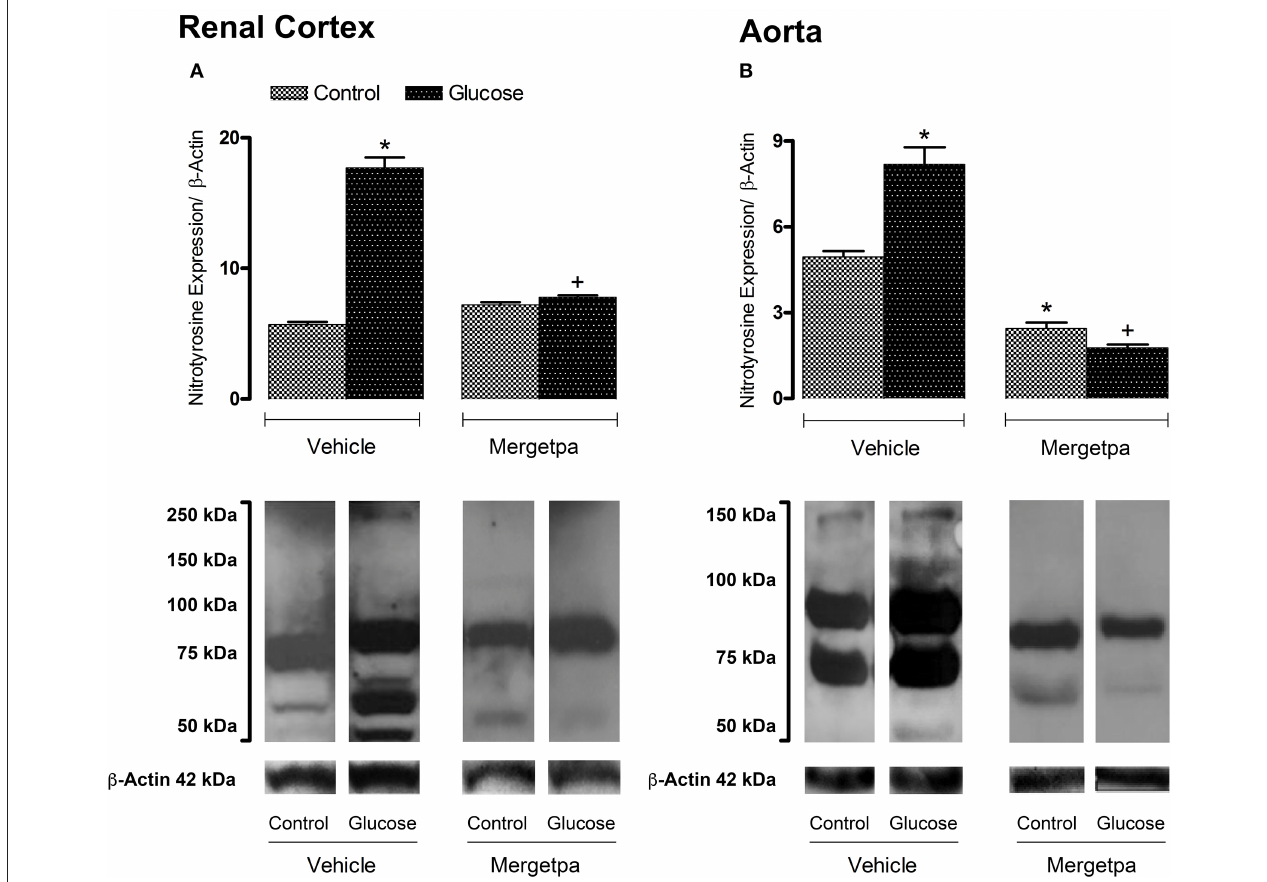
FIGURE 3 | Treatment effect on Nitrotyrosine expression. Effect of s.c. administered Mergetpa (1mg.kg − 1 twice daily) for 7 days on nitrotyrosine expression in (A) renal cortex and (B) thoracic aorta. β -actin was the loading control. Data are mean ± SEM obtained from six rats per group. * P < 0.05 compared with control + vehicle; + P < 0.05 compared with glucose + vehicle. Data in vehicle treated rats are from a previous study (Haddad and Couture, 2016) but performed simultaneously.